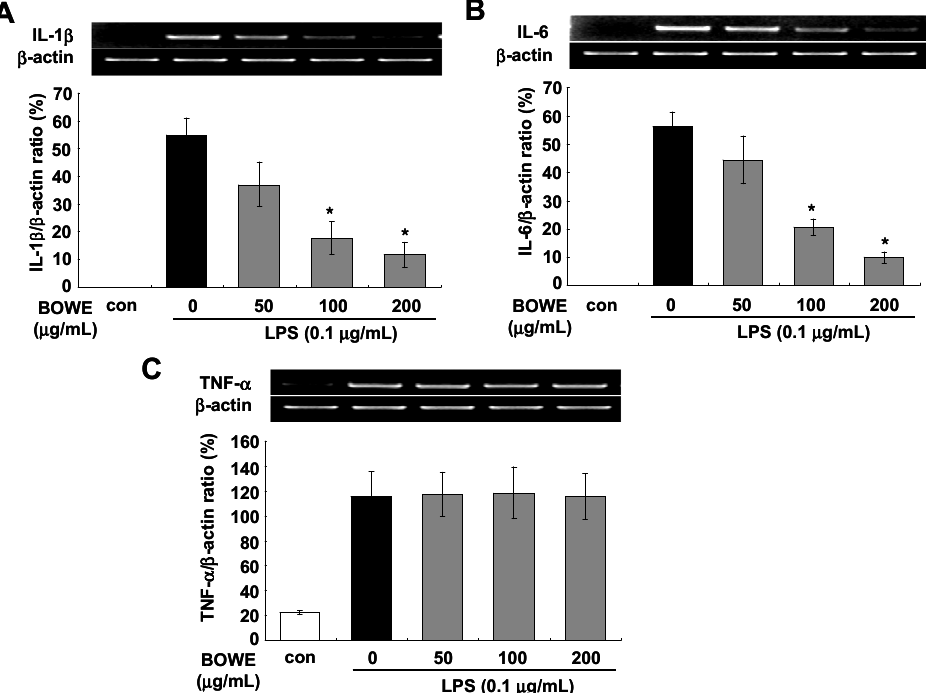
Figure 3. Effect of BOWE on the mRNA expressions of IL-1 β ( A ), IL-6 ( B ), and TNF- α ( C ): BV-2 cells were pretreated with or without the indicated concentrations of BOWE for 4 h and then stimulated with LPS (0.1 μ g/mL) for 18 h. Total RNA was isolated and mRNA expressions of the aforementioned cytokines were measured by RT-PCR. β actin was used as a housekeeping gene. The quantification of relative band intensities from three independent experiments were analyzed by densitometry and expressed as means ± SEM. * p < 0.01 denotes a significant difference compared to the group treated with LPS only.